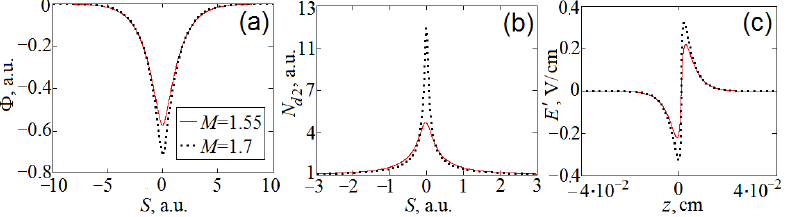
Figure 3. Soliton profiles with M = 1.55 and M = 1.7: ( a ) potential; ( b ) density of the second fraction particles; ( с ) electric field of the soliton.